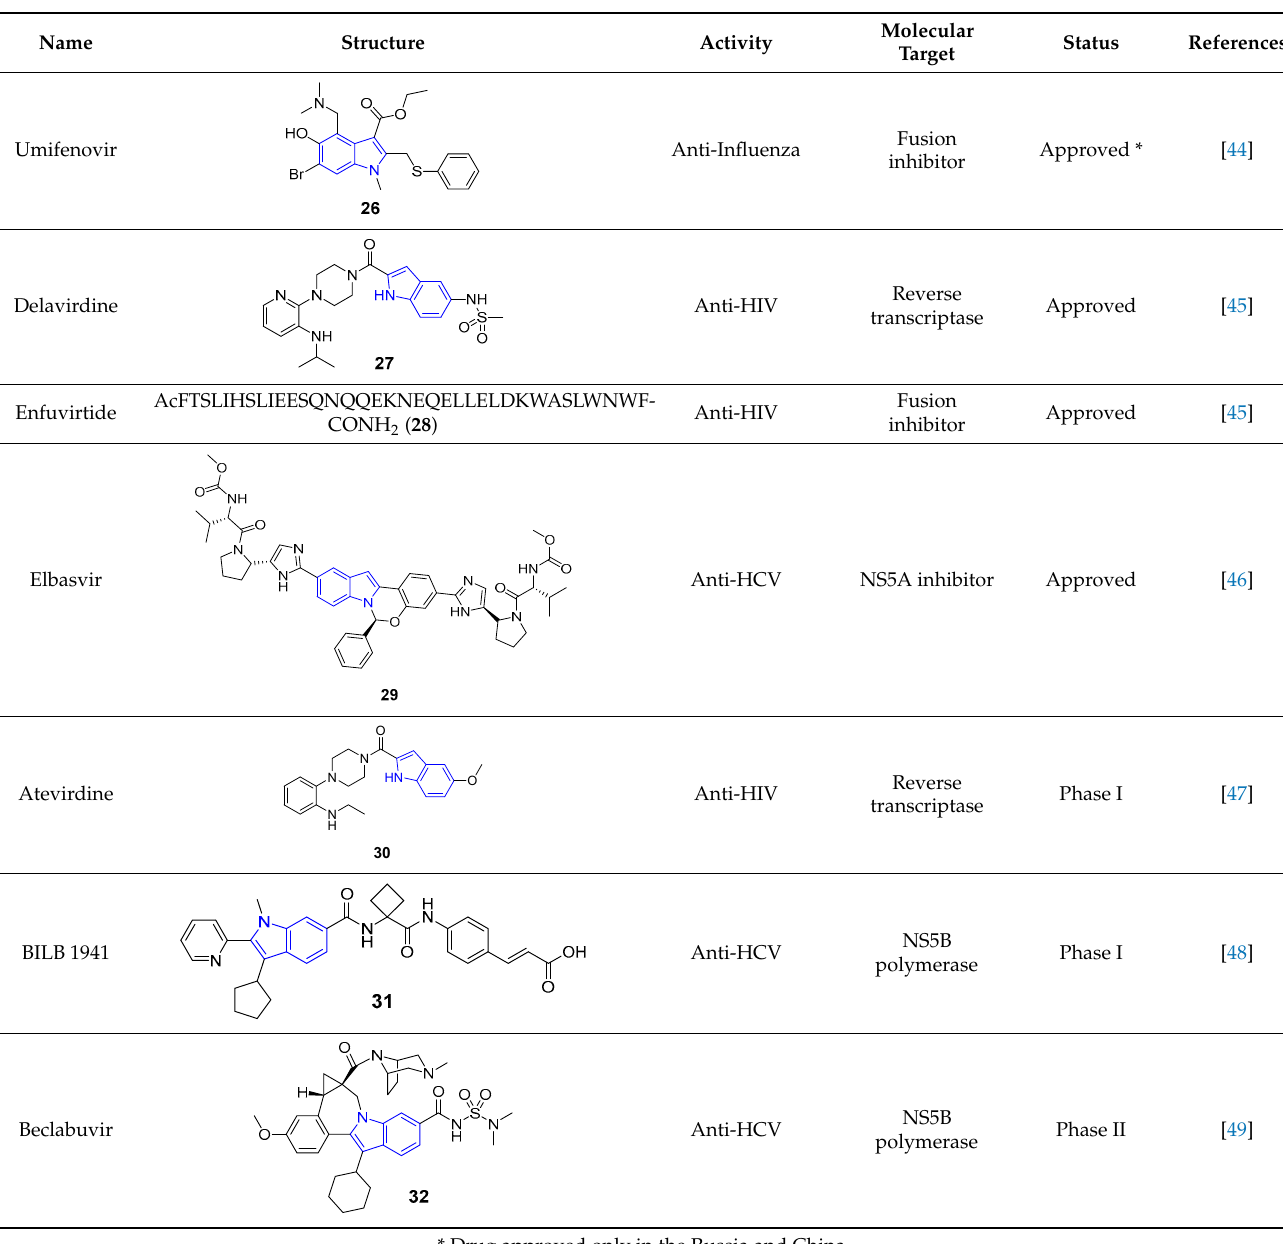
Table 1. Accepted antivirals with indole ring.